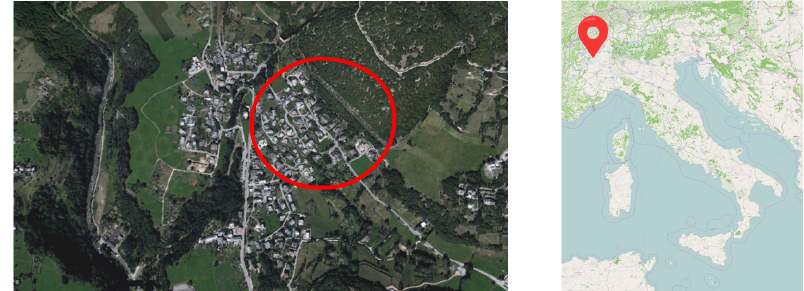
Figure 2. The village of Porossan and its location in Italy. The red circle indicates the area feeder by the substation